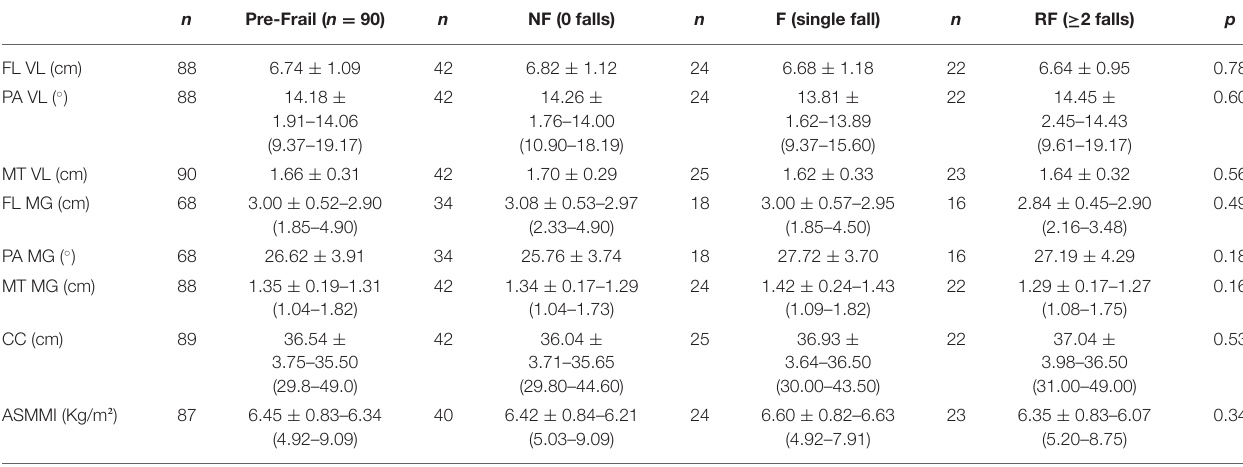
TABLE 4 | Characterization and comparison of muscle architecture and mass in pre-frail non-fallers, fallers, and recurrent fallers older